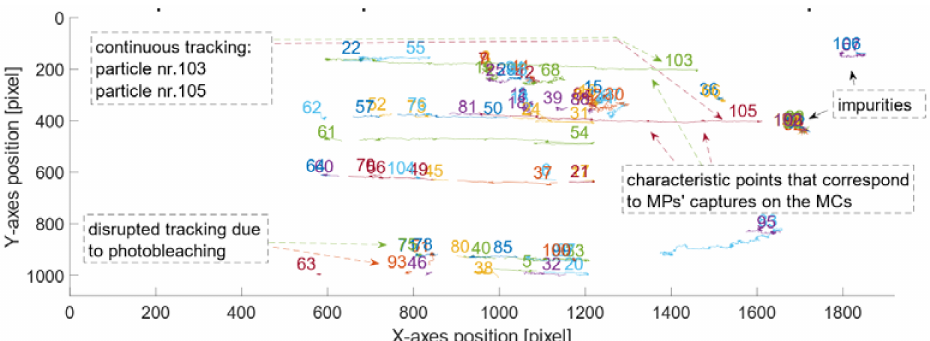
Figure 8. Positions for all detected and tracked particles, without E. coli attached to their surface, over the sequence of frames (1920 × 1080 pixels) collected at 25 fps. The particles were manipulated horizontally. There are some characteristic points visible on these trajectories. They correspond to the position of the MP as it was captured at a MC. There are over 105 trajectories detected for this sample. The MPs were set in motion horizontally i.e., along the x -axes of the frame (for a width of 1920 pixels). The pixels were converted into real dimensions by applying the previously calculated resolution ( Res = 7.2 pix/ µ m). The displacement of the tracked MPs (without E. coli ) over a sequence of frames is presented in Figure 9.